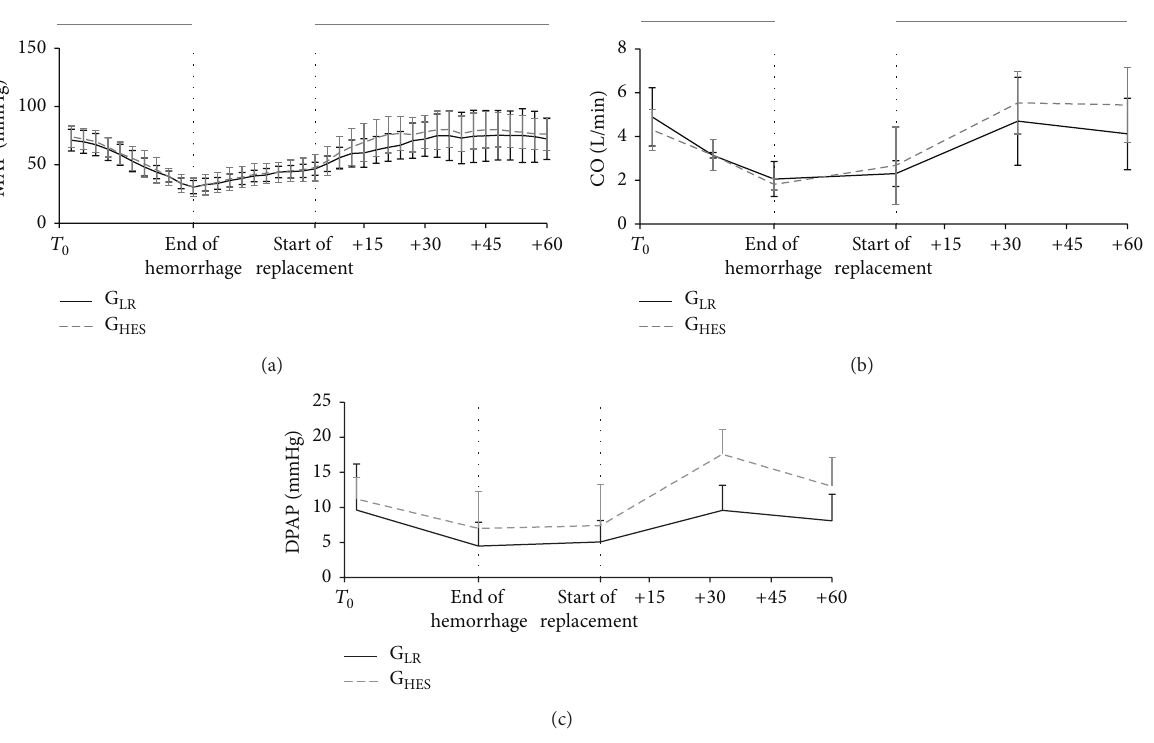
Figure 3: Haemodynamic variables during the four phases of the study: mean arterial pressure (MAP: mmHg), cardiac output (CO: L/min), and diastolic pulmonary artery pressure (DPAP: mmHg). The two groups are shown: G LR : black line and G HES : dashed grey